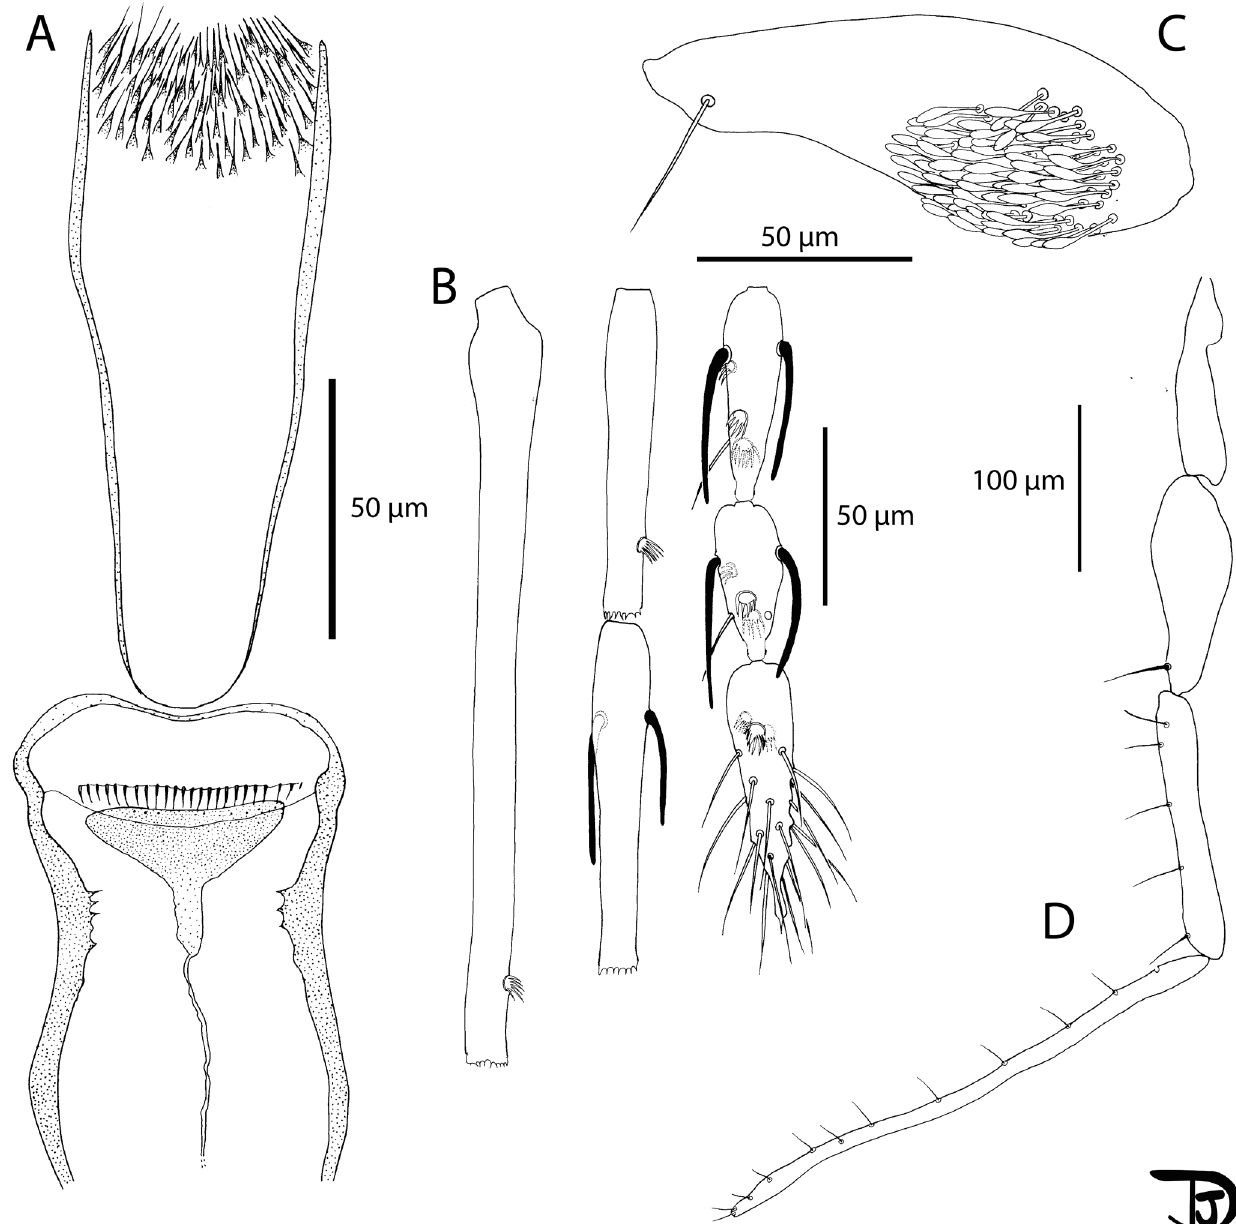
Figure 8. Sergentomyia (Ranavalonomyia) vol fi n. sp. female holotype (MADA1011). (A) pharynx and cibarium, (B) fl agellomeres 1, 2, 3, 12, 13 & 14, (C) third palpal segment, (D)